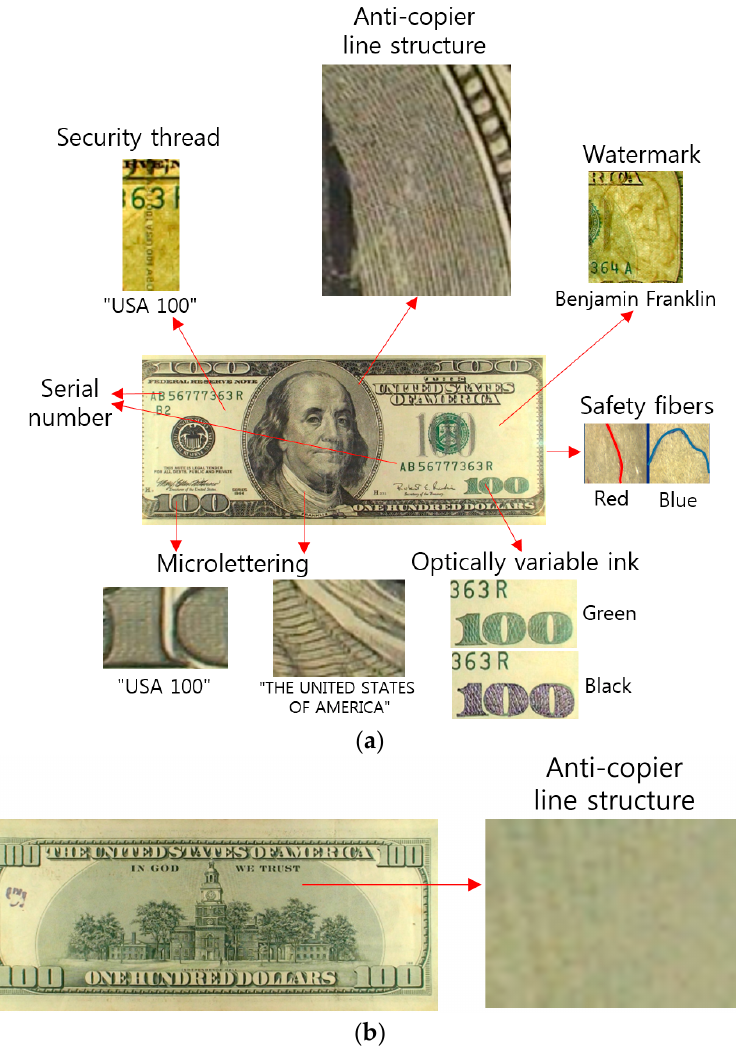
Figure 12. Analysis of anti-counterfeiting features inside a USD 100 bill: ( a ) Front side; ( b ) Back side.